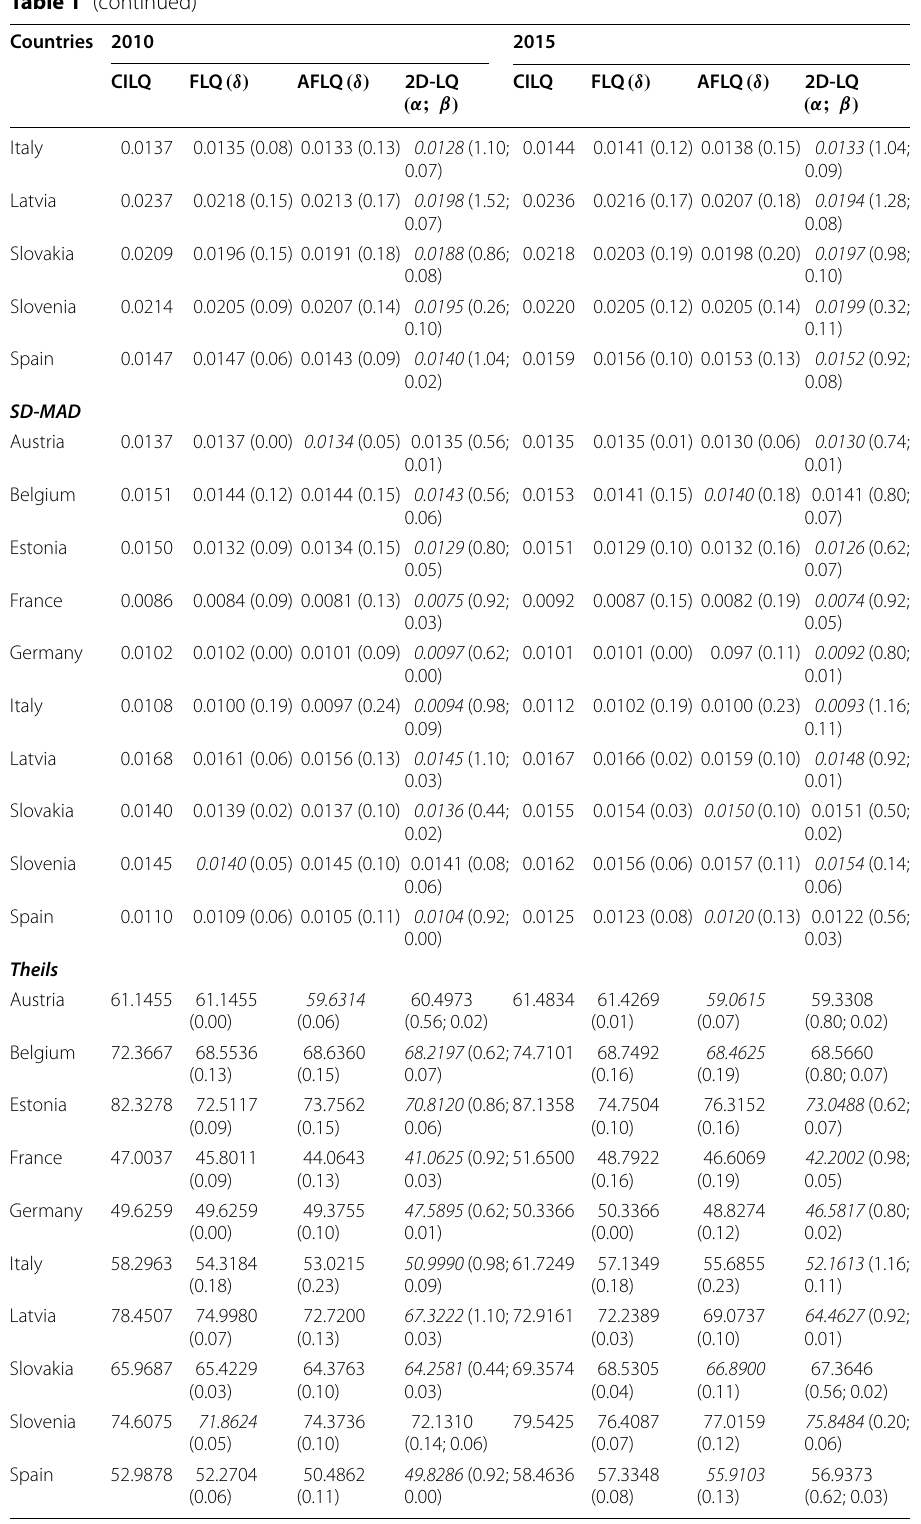
The optimal parameter values for each LQs are indicated in parentheses. The global minimum for the statistic is shown in